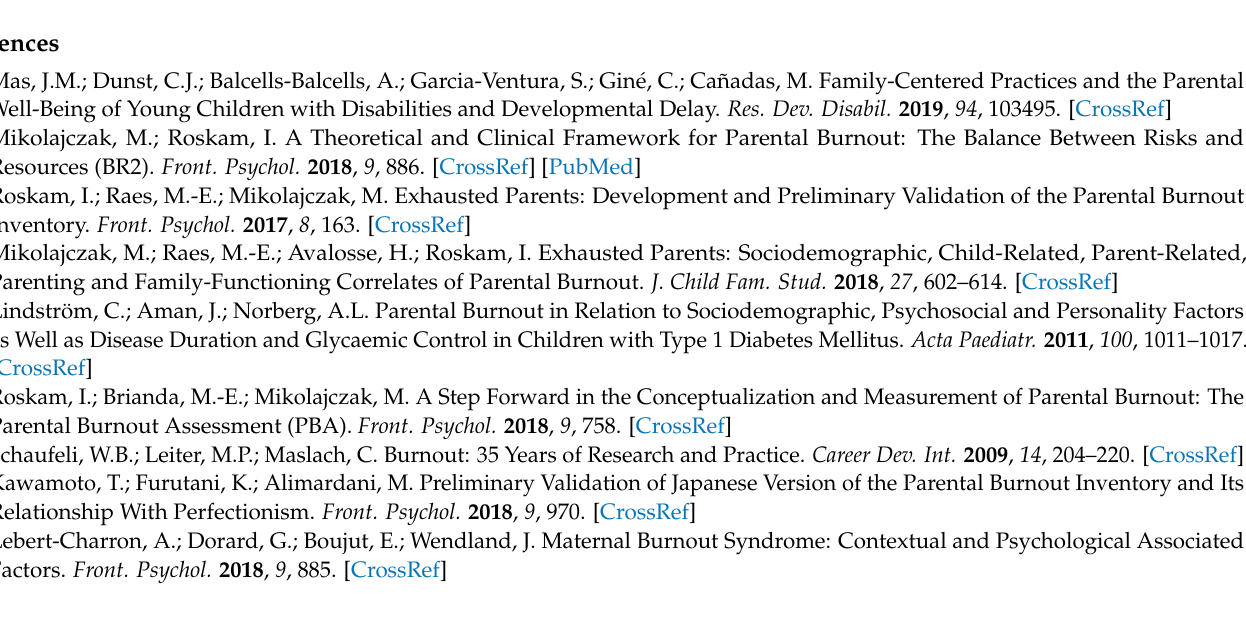
Table S4: Test of a Reduced First Hypothetical Model with Family Satisfaction as an Outcome Variable (After Removing Non-significant Relations from the Initial “Saturated”